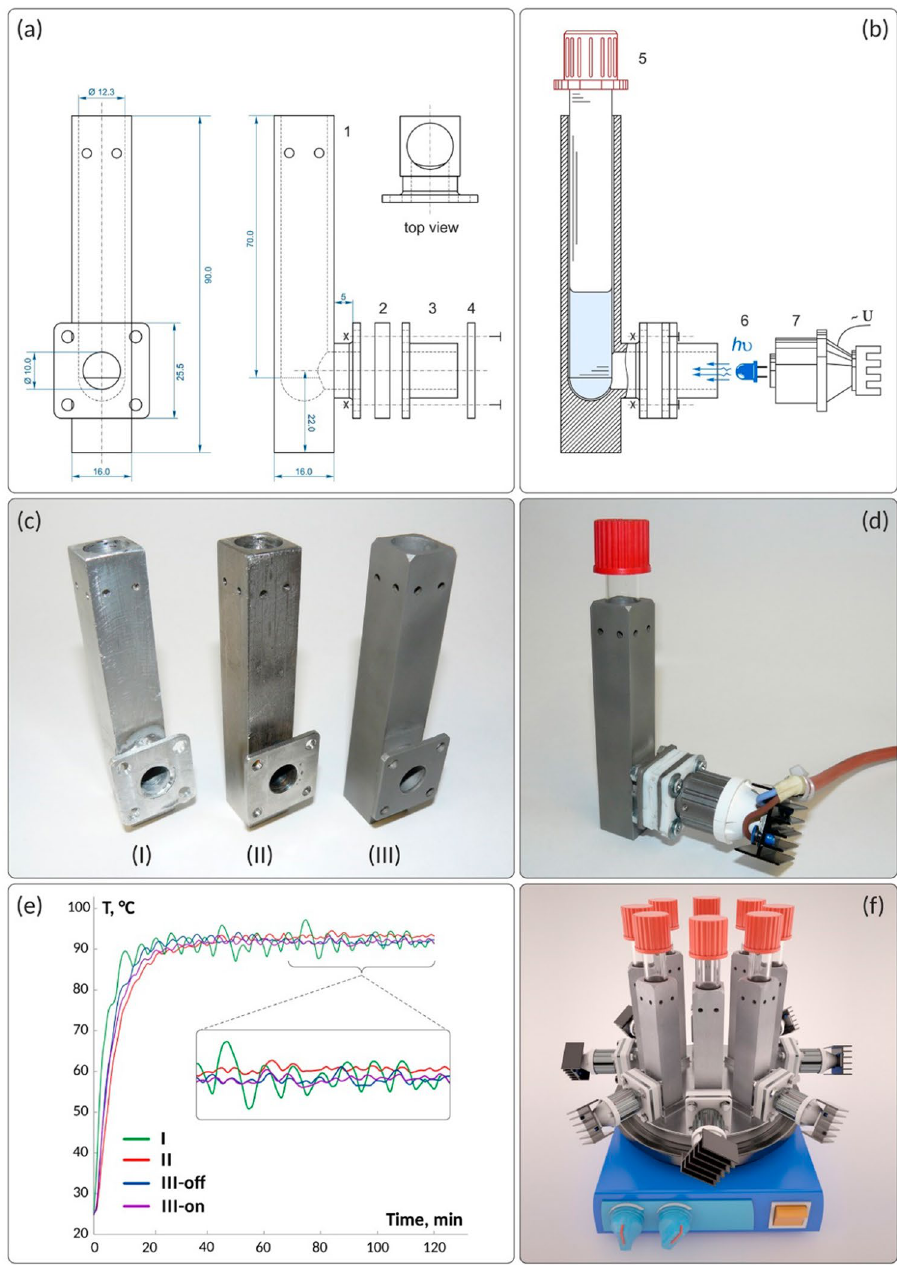
Figure 1. ( a ) Designed photoreactor with main dimensions shown in millimeters; ( b ) schematic representation of the assembling photoreactor with LED and test tube; ( c ) photos of the reactors made by a conventional cutting/milling/welding method from aluminum alloy (I) and stainless steel (II), as well as a reactor made of stainless steel by DMLS 3D printing (III); ( d ) photo of the assembled reactor with a test tube inside and a connected LED light source; ( e ) monitoring of temperature stability over a time period of 2 h in DMF solution at 90 °C for the following photoreactors: I—aluminum alloy and II—stainless steel reactors manufactured by conventional method; III-off and III-on—3D printed stainless-steel reactor with LED switched off and with LED switched on, respectively; ( f ) a 3D model showing several photoreactors for parallel operation under temperature